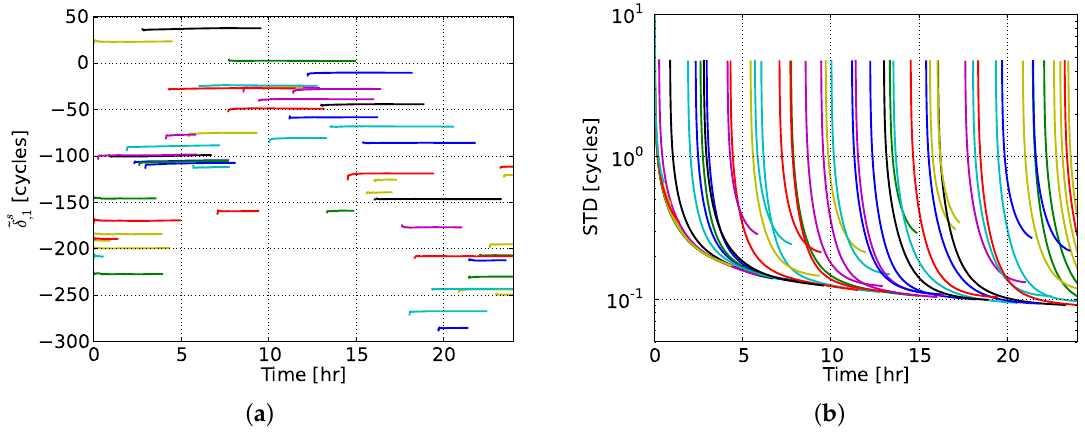
Figure 4. ( a ) Satellite phase bias estimates on L1 (in cycles) and ( b ) their formal standard deviations for all GPS satellites during the selected day. Each color represents a different GPS